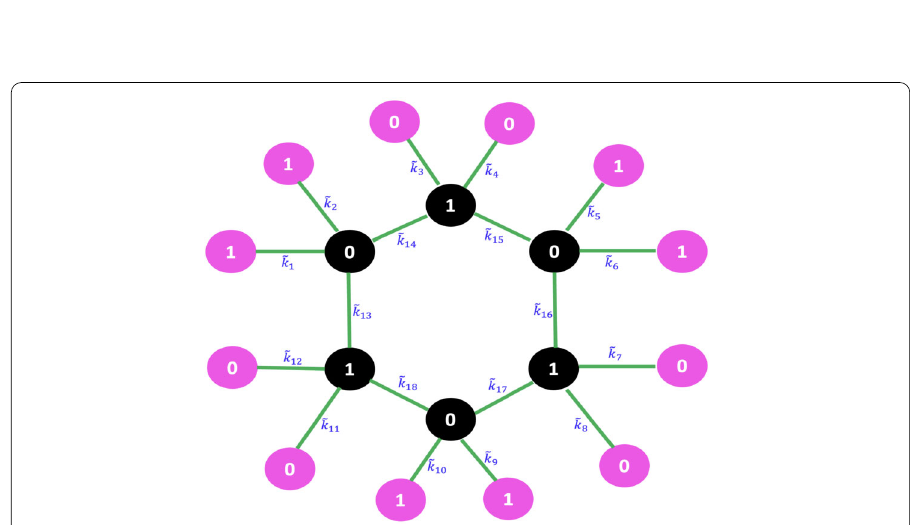
Figure 3 A hexasilinane compound graph with vertices 0 or 1